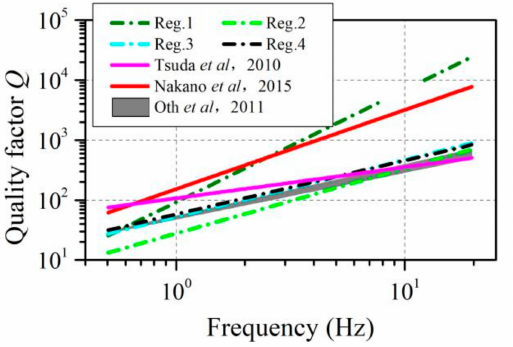
Figure 10. Comparison of Q value fitting curves between this study and other